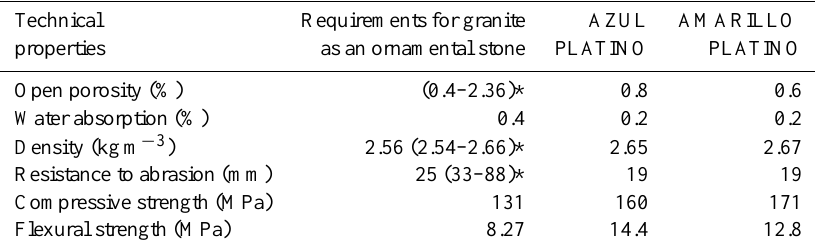
Table 1. Technical properties of two different facies of the bluish granite, Azul Platino and Amarillo Platino (Junta de Extremadura, 2004), and requirements for the use of granite as an ornamental stone (ASTM, 2008).